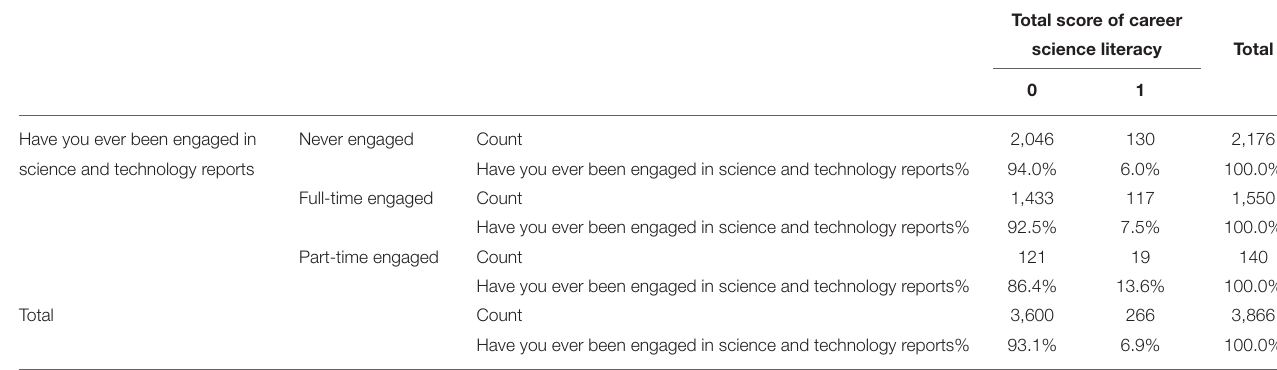
TABLE 1 | Have you ever been engaged in science and technology reports * career science literacy cross-list.